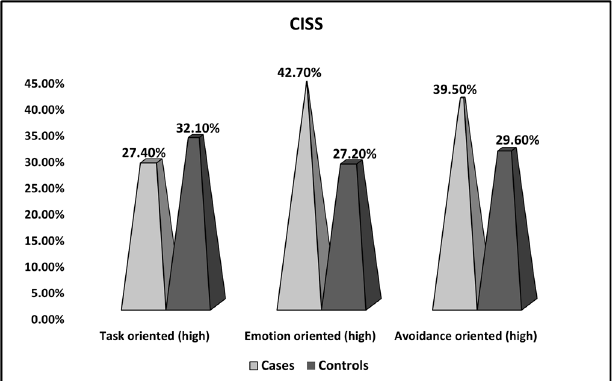
Figure 1. Comparison of CISS survey results between women with thrombophilia and recurrent pregnancy loss (cases), women with thrombophilia and recurrent pregnancy loss who achieved a normal pregnancy, and preterm or full-term birth (controls). Table 4. Comparison of SII and DSCS survey results between women with thrombophilia and recurrent pregnancy loss (cases), women with thrombophilia and recurrent pregnancy loss who achieved a normal pregnancy, and preterm or full-term birth (controls).